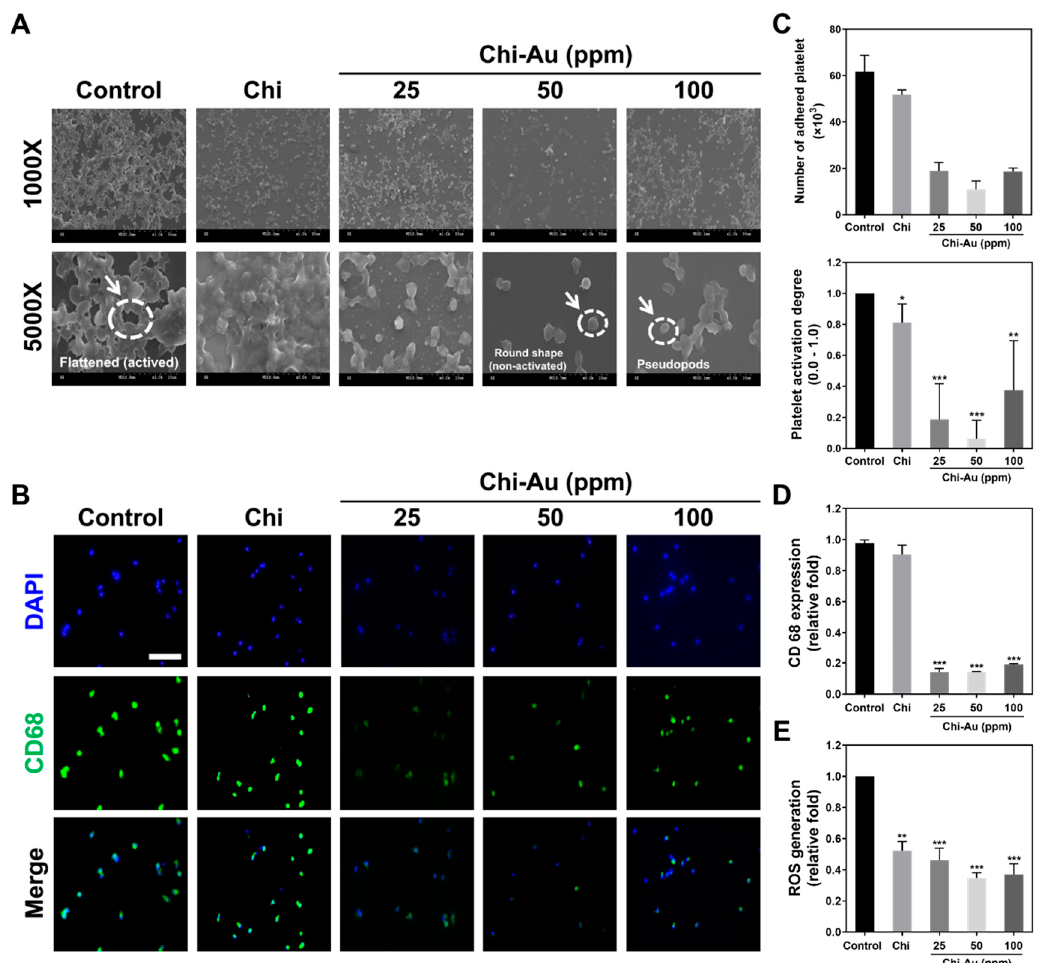
Figure 3. Biocompatibility assessments of the Chi–Au nanocomposites. ( A ) The platelet activation culturing on various nanocomposites was observed by SEM after 24 hours’ incubation. The flattened platelet cells constituted the activated form (white arrow in the Control), while the non-activated platelet cells were observed to have a round shape (white arrow in the Chi–Au 50 ppm). The white arrow in Chi–Au 100 ppm indicated pseudopod morphology of platelet cell. ( B ) The CD68 macrophage marker expressed in monocytes was detected through IF staining after 96 h. The monocytes were immunostained with primary anti-CD68 antibodies and conjugated with secondary FITC antibodies (green fluorescence). DAPI solution was used to detect nuclei (blue fluorescence). Scale bars measure 20 μ m. ( C ) The number of adhered platelet cells and degree of activation were quantified. Based on the results, Chi combined with 50 ppm of Au nanoparticles induced the lowest amount of adherence and degree of activation of the platelet cells. ( D ) The expression of CD68 in the monocytes was semi-quantified based on fluorescence density. The expression of CD68 was significantly decreased in the Chi–Au groups. ( E ) The intracellular ROS generation of MSCs seeded on various nanocomposites was targeted by DCFH-dA probe and semi-quantified through flow cytometry. Data are represented by one of three independent experiments. * p < 0.05, ** p < 0.01, *** p < 0.001: compared with the control